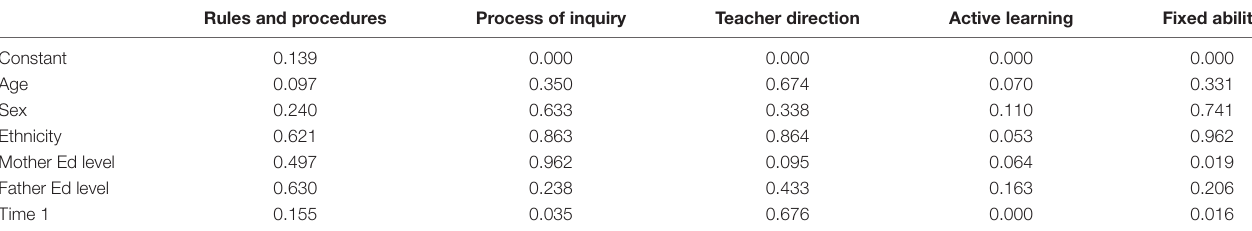
TABLE 5 | Summary of p values for linear regressions by survey category from Time 1 to Time 2 with Time 2 as the dependent